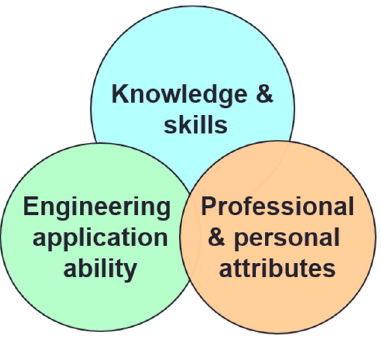
Figure 2. Engineers Australia, Stage 1 competency schema.